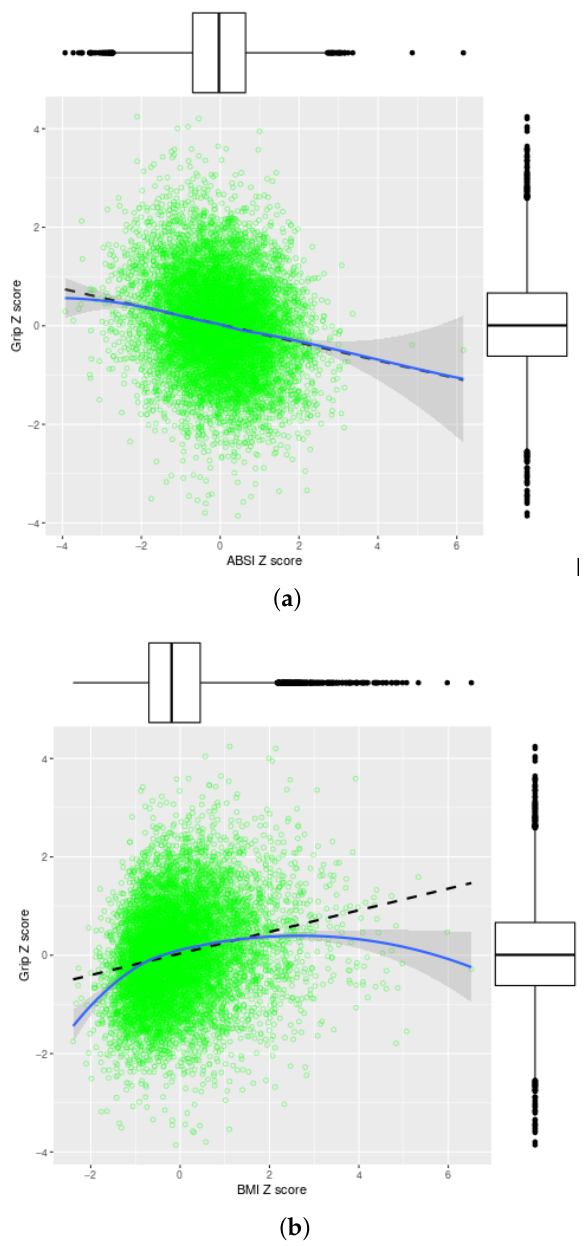
Figure 1. Grip strength versus ( a ) ABSI and ( b ) BMI Z score in NHANES 2011–2014. The dashed black line shows the least-squares linear fit. The solid blue line shows a local polynomial (LOESS) fit, with the shading indicating a 95% confidence interval for the fit. The axis box and whisker plots show the marginal distributions. ABSI = a body shape index, BMI = body mass index, Grip = hand grip